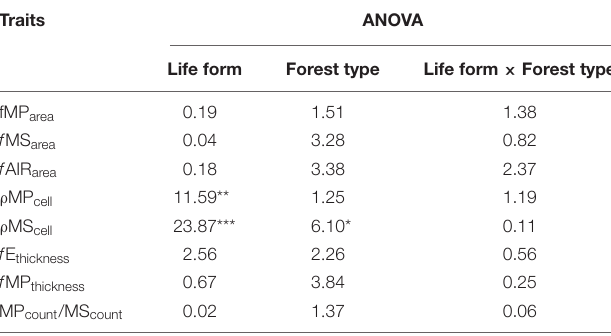
TABLE 5 | Results of the ANOVA comparison of the effect of life forms, forest type, and their interaction on the derived leaf anatomical traits. Traits